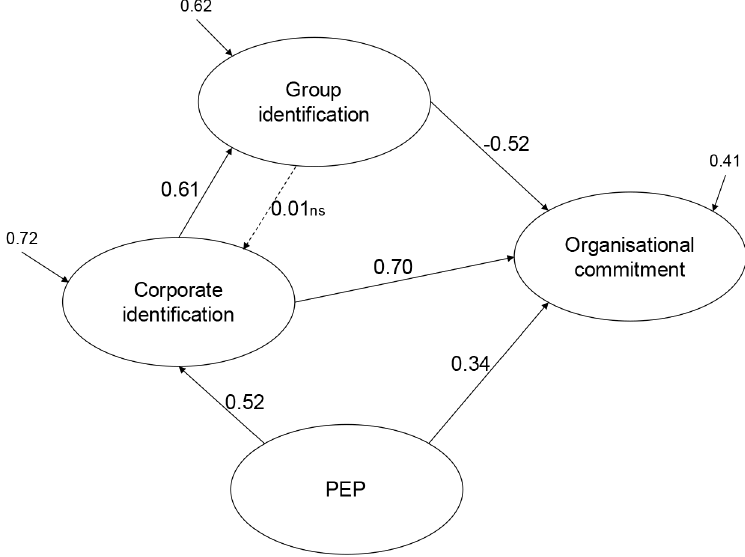
Fig. 1. Structural model – standardised paths among latent